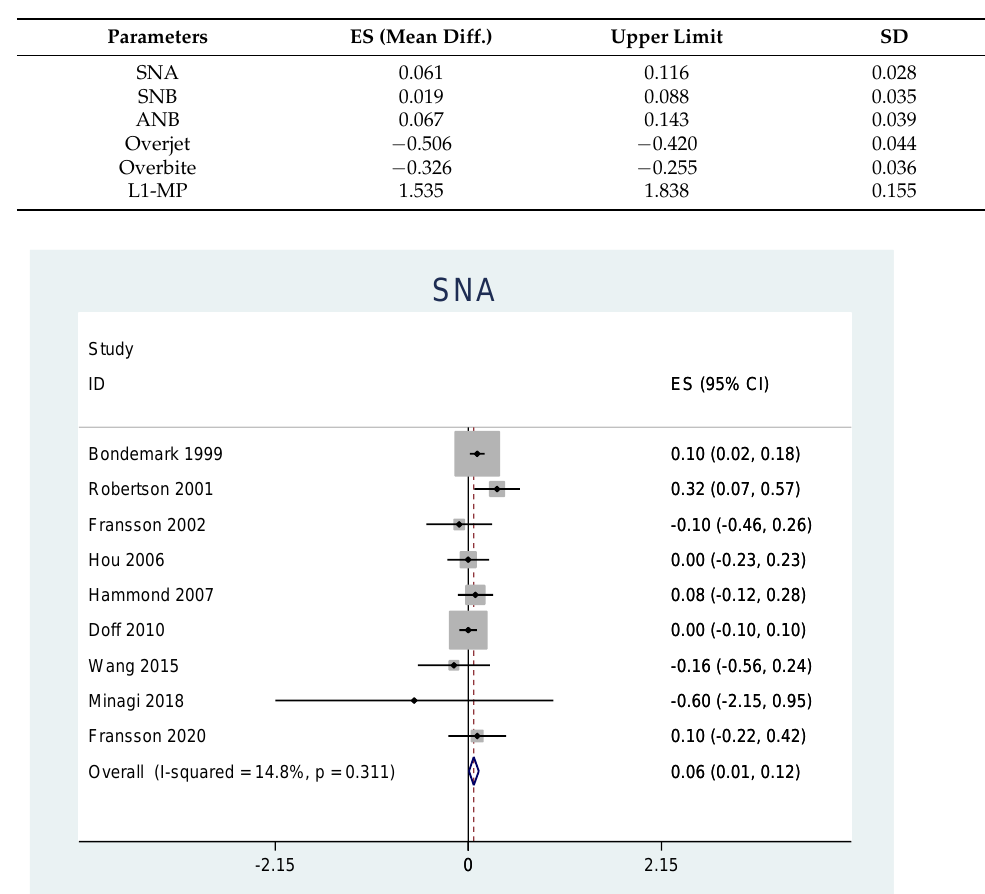
Table 6. Overall results of meta-analysis. Mean difference, upper limit, and standard deviation.